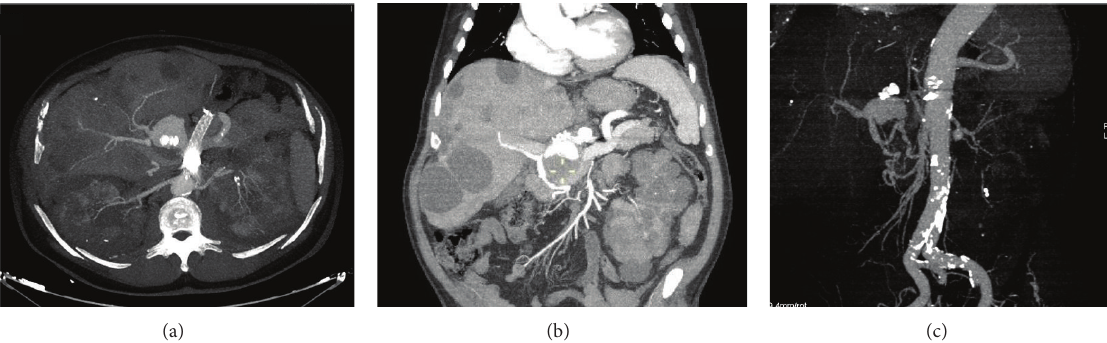
Figure 4: CT scan after 5 years from intervention. (a) MIP reconstruction in the axial plane showing aneurysm relapse in the hepatic artery; patency of the stent in the splenic artery is also evident; MIP (b) and VR (c) reconstructions in coronal and sagittal oblique planes demonstrating the pancreaticoduodenal arcade supplying the aneurysm relapse; the vascular plug, previously positioned, is noted. Renal and hepatic cysts are observable in Figure (b).